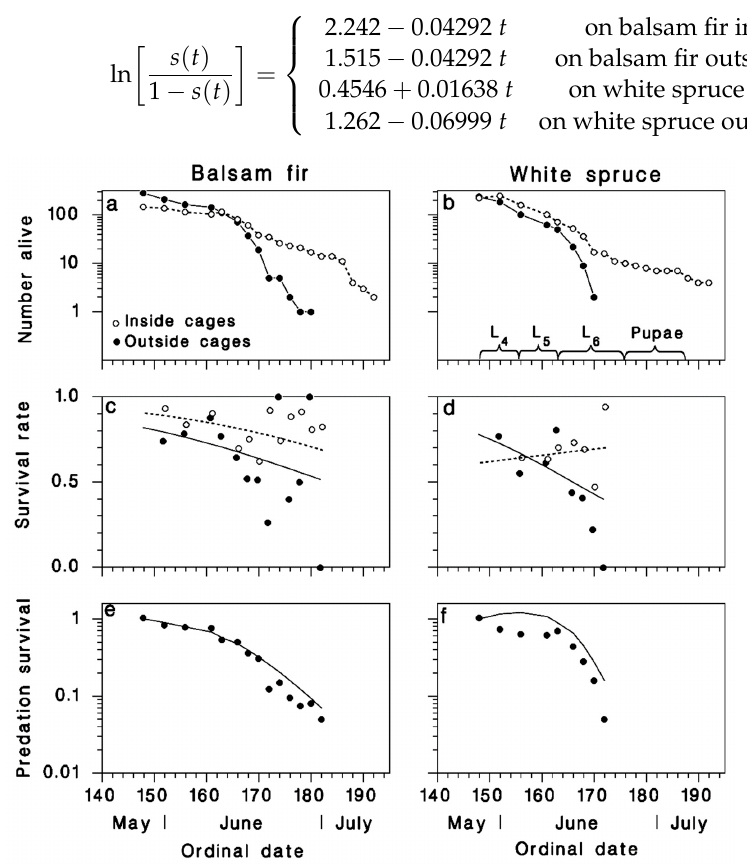
Figure 5. Survival among implanted cohorts in Armagh in 1988 on ( a , c , e ) balsam fir and ( b , d , f ) white spruce (Open circle: inside cages; closed cirles: outside cages). ( a , b ) number of live individuals. ( c , d ) Survival rate (lines: Equation (8); dotted: inside cages; solid: outside cages). ( e , f ) survival from predation calculated with Equation (5). Table 3. Results of binary logistic regression of survival (Equation (3)) among cohorts in Armagh in 1988 ( s : host species; ca : the presence of exclosure cages; t ordinal date). The reduced model is Equation